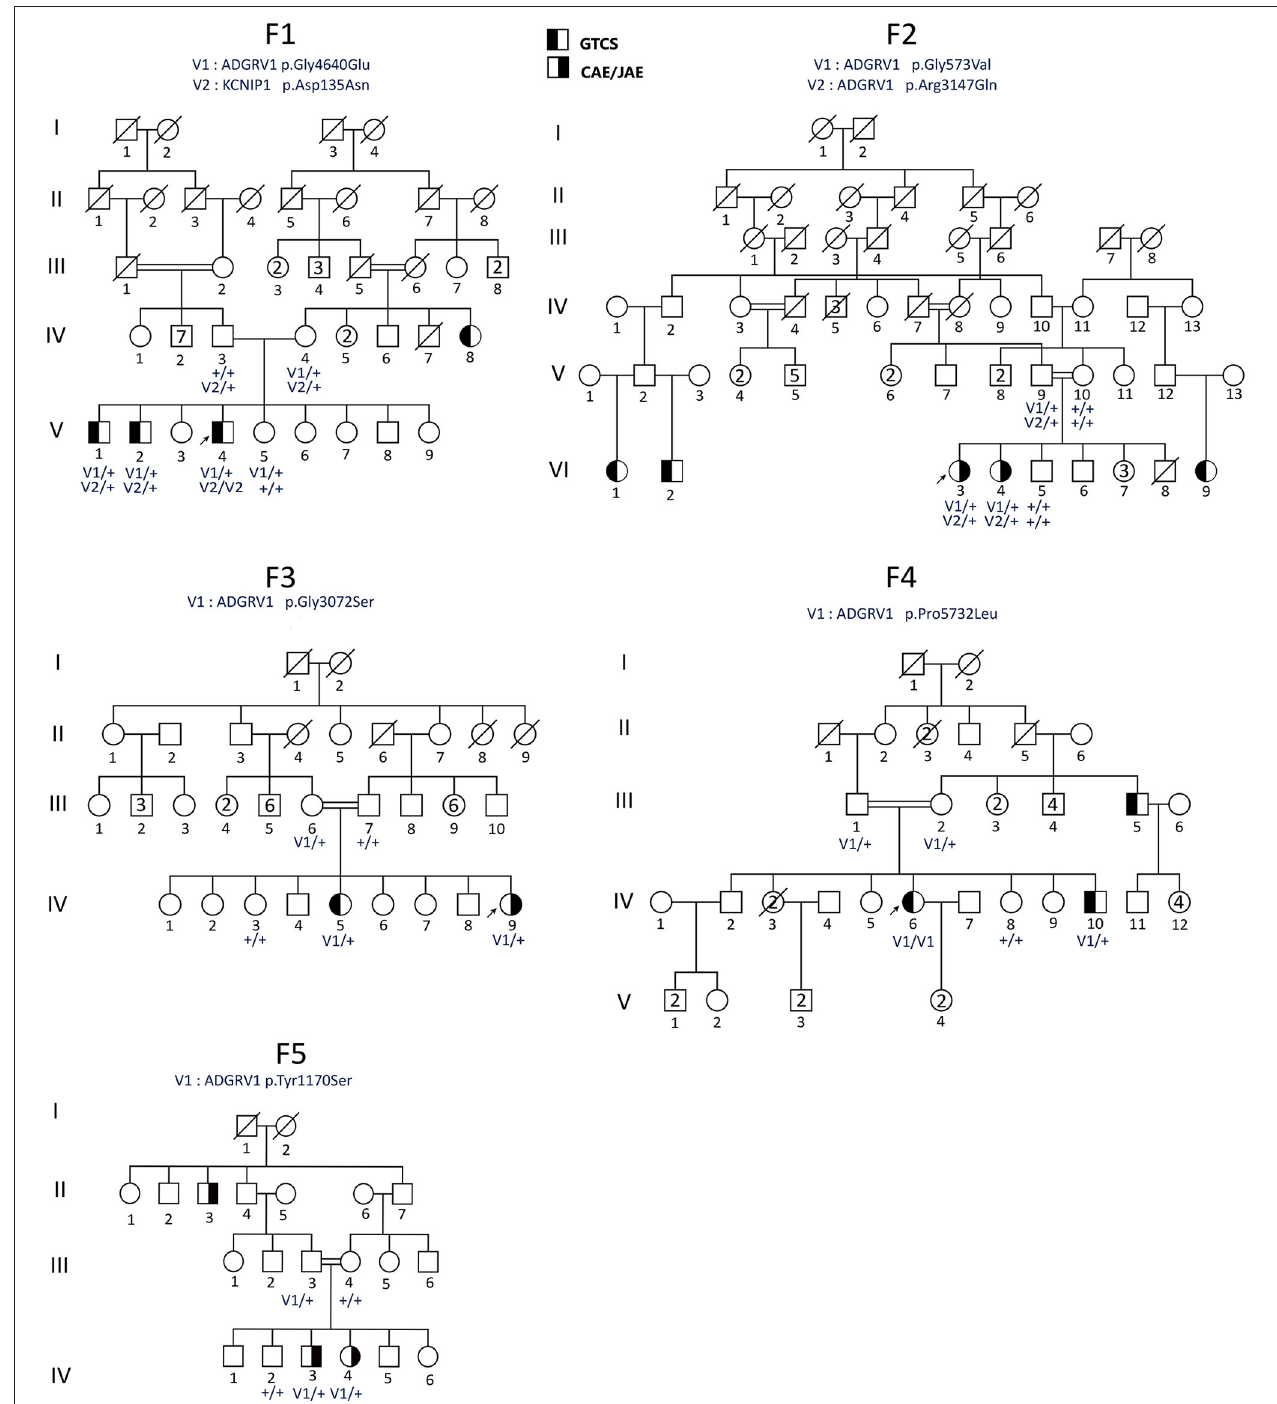
FIGURE 1 | Pedigrees of the Sudanese families (F1–F5) with ADGRV1 variants. Males are represented by squares and females by circles, the probands are shown by arrows, and a diagonal line through the symbol denotes deceased subjects. CAE, childhood absence epilepsy; GGE-TCS, GGE with tonic–clonic seizures alone. Genotypes are indicated below the tested